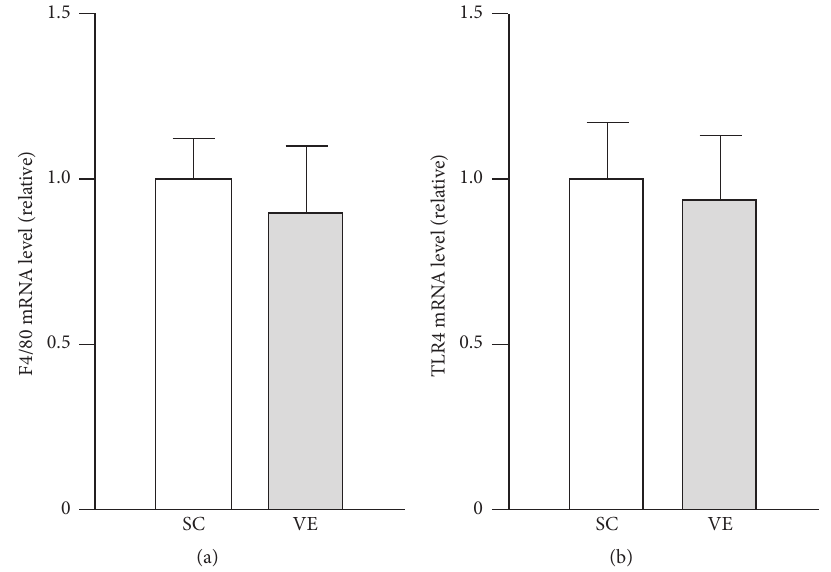
Figure 2: Effects of regular voluntary exercise (VE) on the mRNA levels of F4/80 and TLR4 in macrophages. Immediately after peritoneal- exudate macrophages were isolated from the sedentary control (SC) and VE mice, total cellular RNA were extracted. The mRNA levels of F4/80 (a) and TLR4 (b) were analyzed by real-time polymerase chain reaction (PCR). The mRNA levels are presented as ratios relative to the levels of 18S rRNA. Mean ± standard error of the mean (SEM; 𝑛 = 4 ) values are provided.